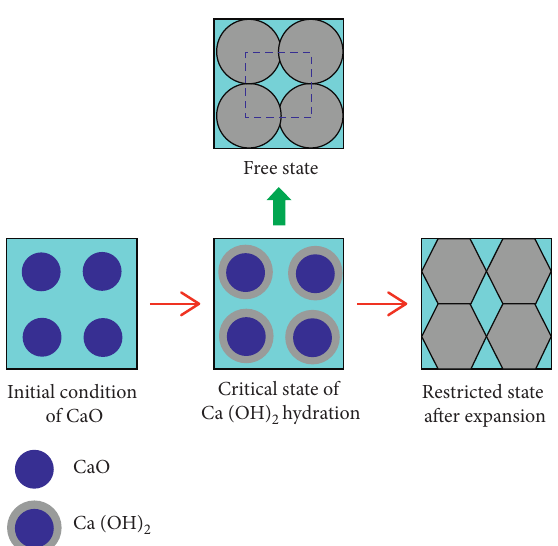
Figure 3: Molecular model structure after chemical reaction of expansive